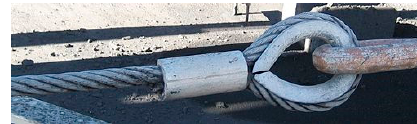
Figure 52. A wire rope terminated in a loop (Flemish eye) with a thimble and ferrule.